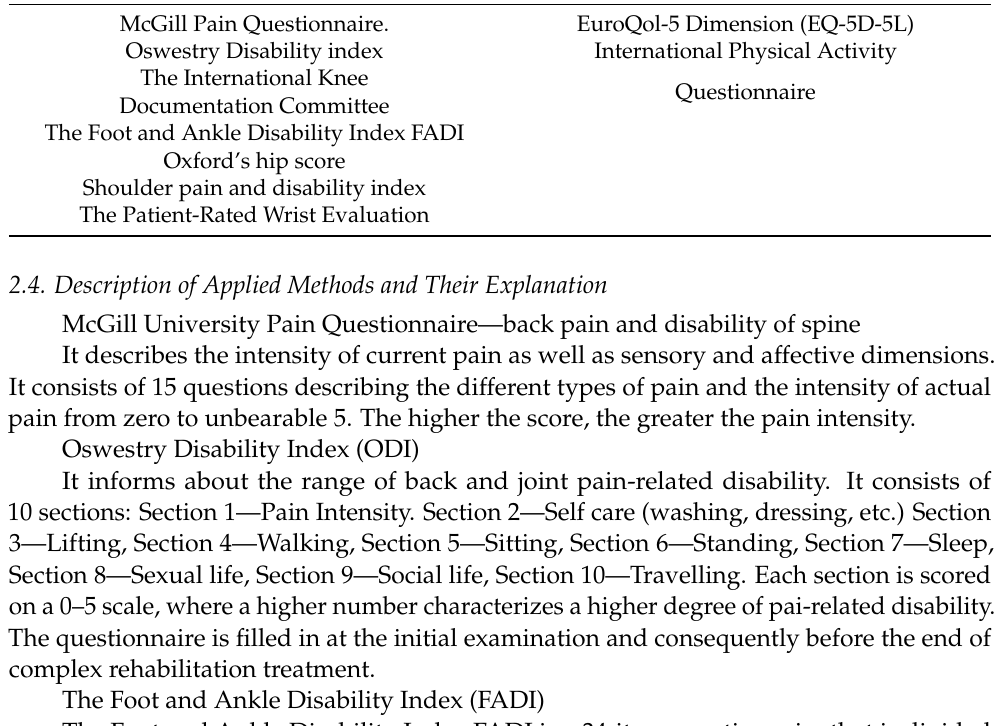
Table 3. List of questionnaires used in the study. Disability and Injuries Quality of Life and PA McGill Pain